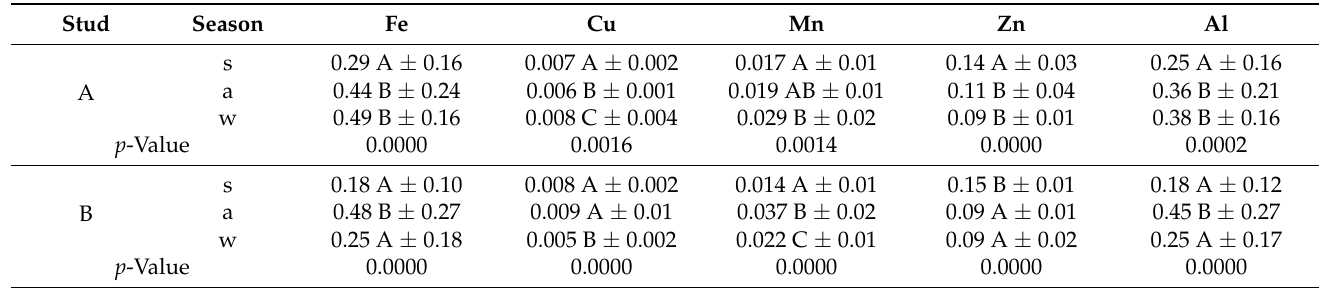
Table 3. Selected micronutrients in the coat of Hucul horses depending on the season (mean ± SD) (mg · g − 1